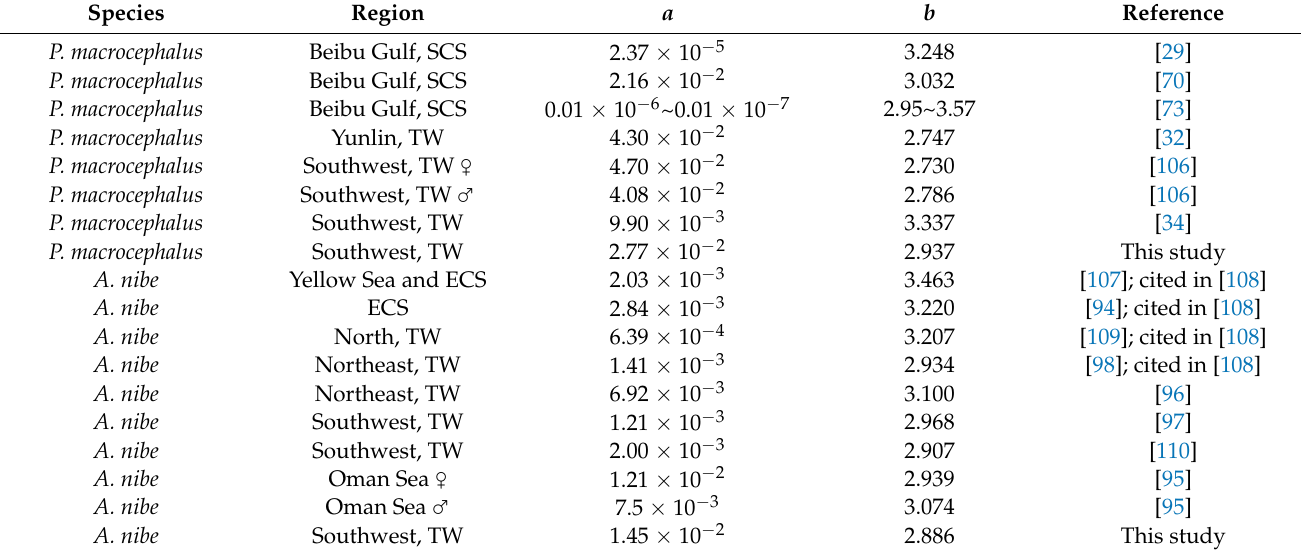
Table 3. The coefficients a and b of the length–weight relationship equation (LWR) of P. macrocephalus (standard length) and A. nibe (total length) of the current and previous